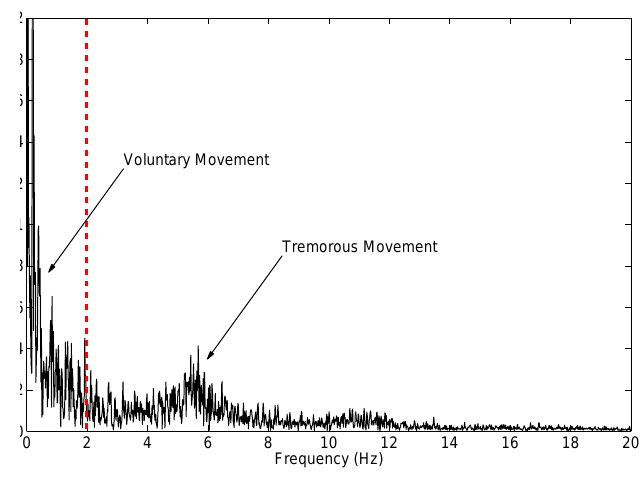
Figure 3 . Power spectral density of wrist rotation during a finger to nose task performed by patient 01. It is observed that voluntary movement (below 2 Hz) has considerably more energy than tremorous movement (centered around 5.5 Hz). Dashed red line separates energy attributed to voluntary (left) and tremorous motion